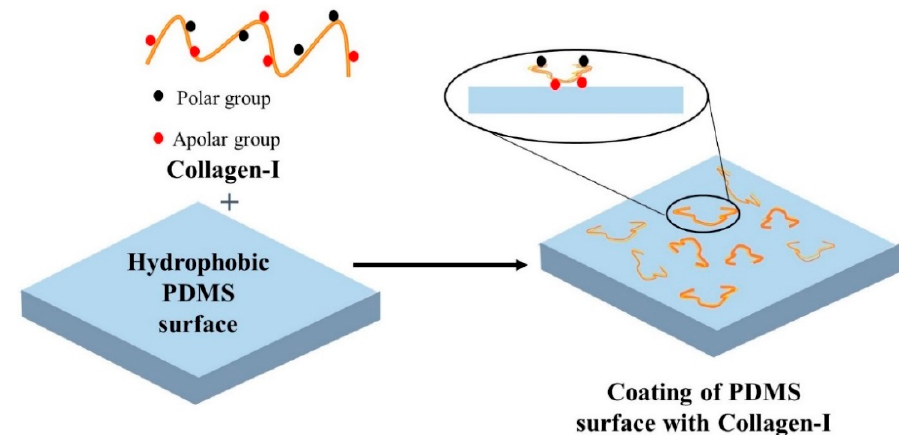
Figure 3. Schematic presentation of PDMS surface modification by collagen-I. The polar groups of collagen-I covalently bind with the PDMS surface and self-assemble to provide the platform for cell attachment.